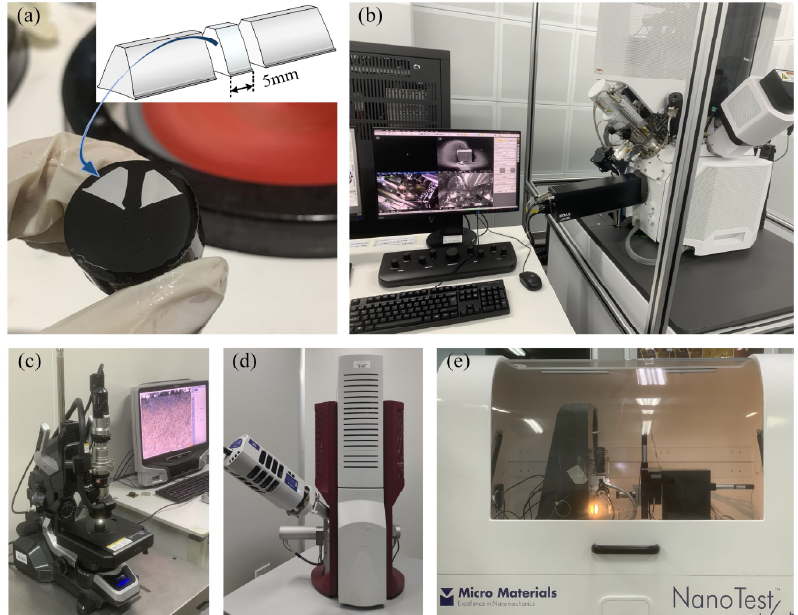
Figure 2. Testing experiment of gear surface integrity after machining: ( a ) metallographic sample preparation. ( b ) Electron Backscattered Diffraction (EBSD) measurement of the microstructure. ( c ) Super-depth-of-field microscopy to observe the surface metallography. ( d ) Scanning electron microscope (SEM) test of the processed surface. ( e ) Nanoindentation hardness test of tooth flank.